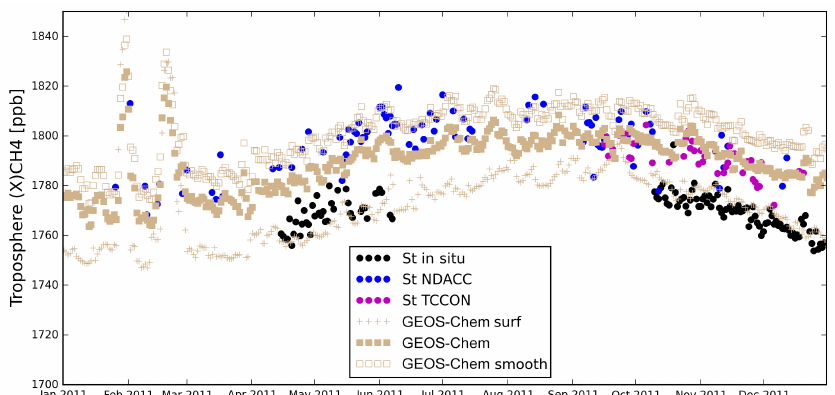
Figure 12. The time series of CH 4 daily means from the in situ measurements (black dots), NDACC tropospheric X CH (purple dots) at St Denis, in addition to the GEOS-Chem model simulations of the VMR at the surface (brown TCCON tropospheric X CH 4 (brown filled squares) and tropospheric X CH cross), tropospheric X CH 4